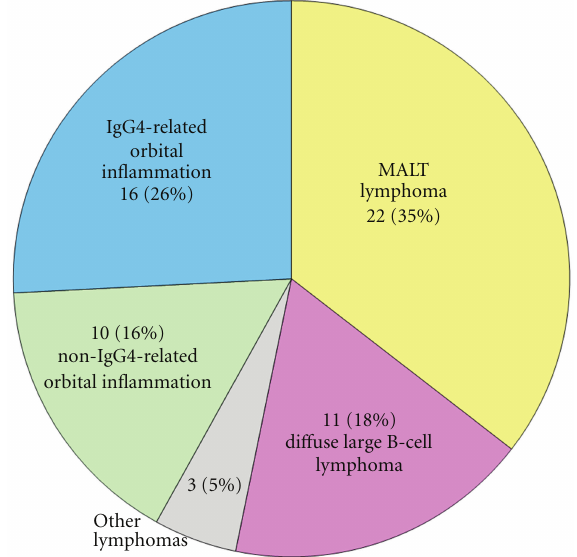
Figure 1: Breakdown of diagnosis in orbital lymphoproliferative disorders. Patients were a consecutive 62 case series with or- bital lymphoproliferative disorders pathologically diagnosed from November, 2004, to March, 2011, in Kanazawa University Hos- pital, Japan. Cases with conjunctival and intraocular lesions were excluded. MALT lymphoma is an abbreviation for extranodal mar- ginal zone B-cell lymphoma of mucosa-associated lymphoid tissue.